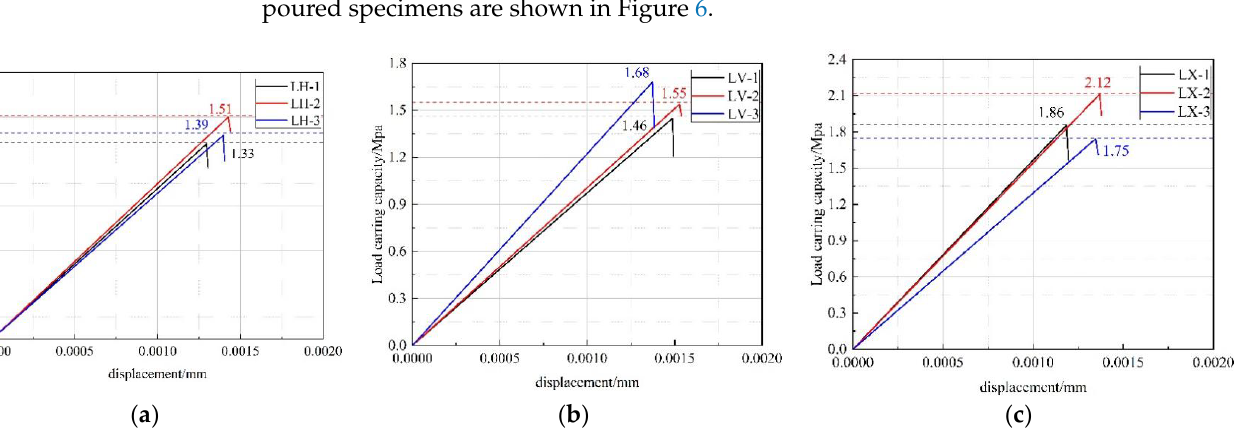
Figure 6. Load–displacement curves associated with the axial tension test. ( a ) Specimen printed horizontally ; ( b ) Specimen printed vertically ; ( c ) Poured specimens .